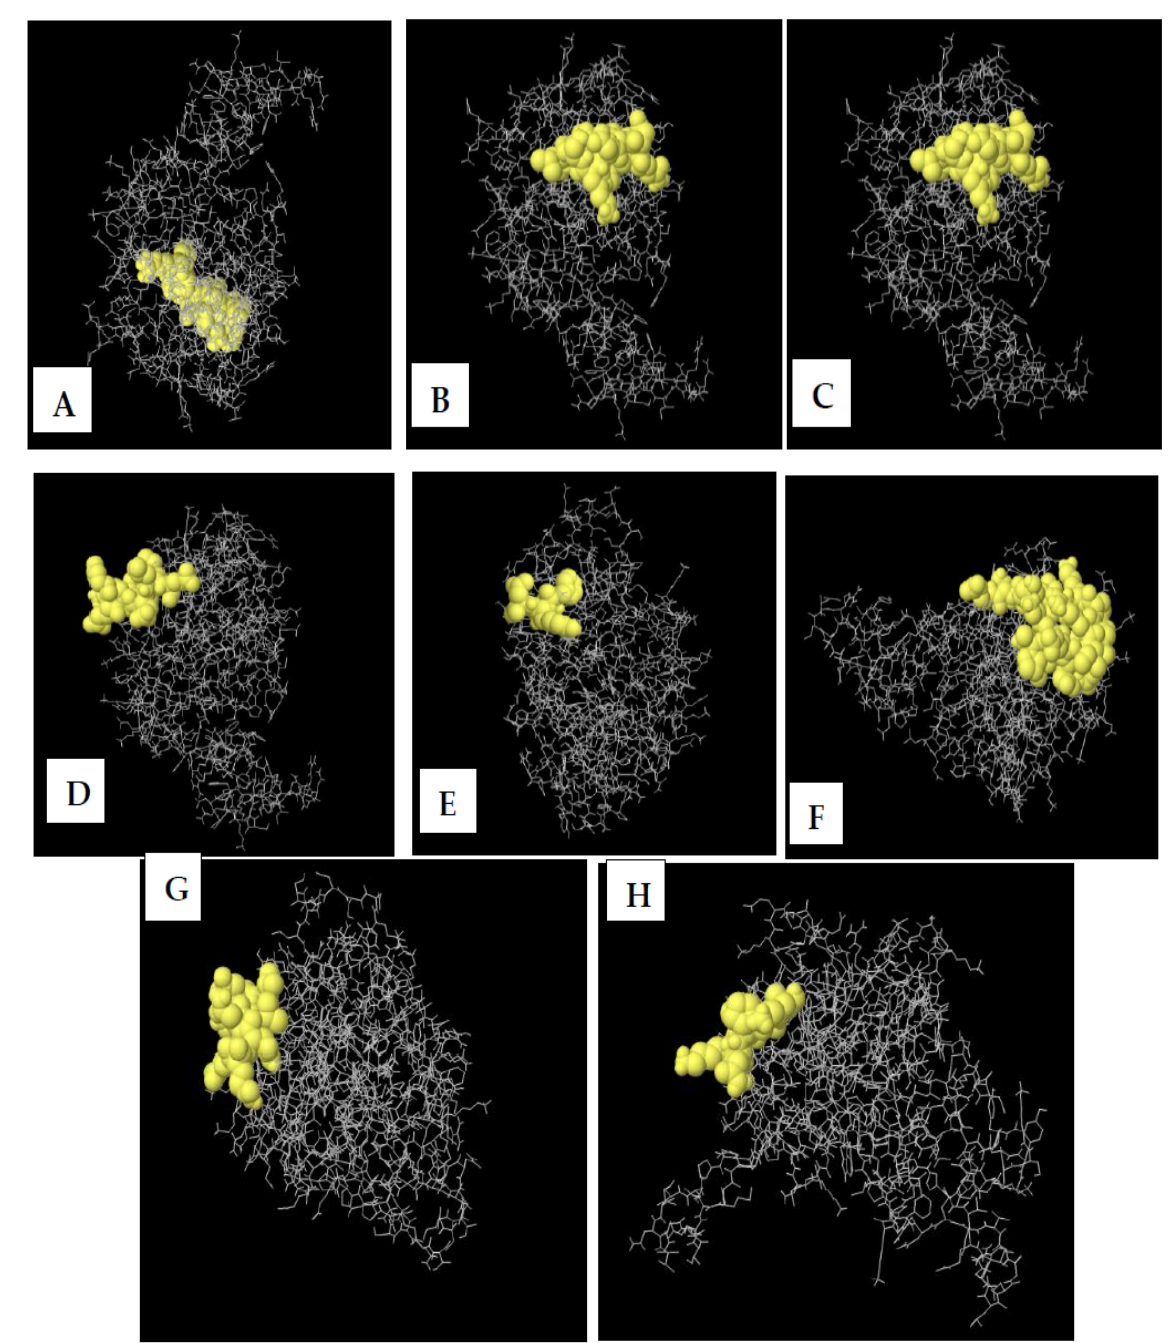
Figure 7. The 3D model of the 8 predicted conformational B-cell epitopes. The yellow regions are the conformational B-cell epitopes, while the grey regions are the residue remnant. ( A ) 18 residues with 0.856 score. ( B ) 32 residues with 0.825 score. ( C ) 12 residues with 0.76 score. ( D ) 11 residues with 0.686 score. ( E ) 4 residues with 0.681 score. ( F ) 19 residues with 0.624 score. ( G ) 8 residues with 0.613 score. ( H ) 6 residues with 0.589